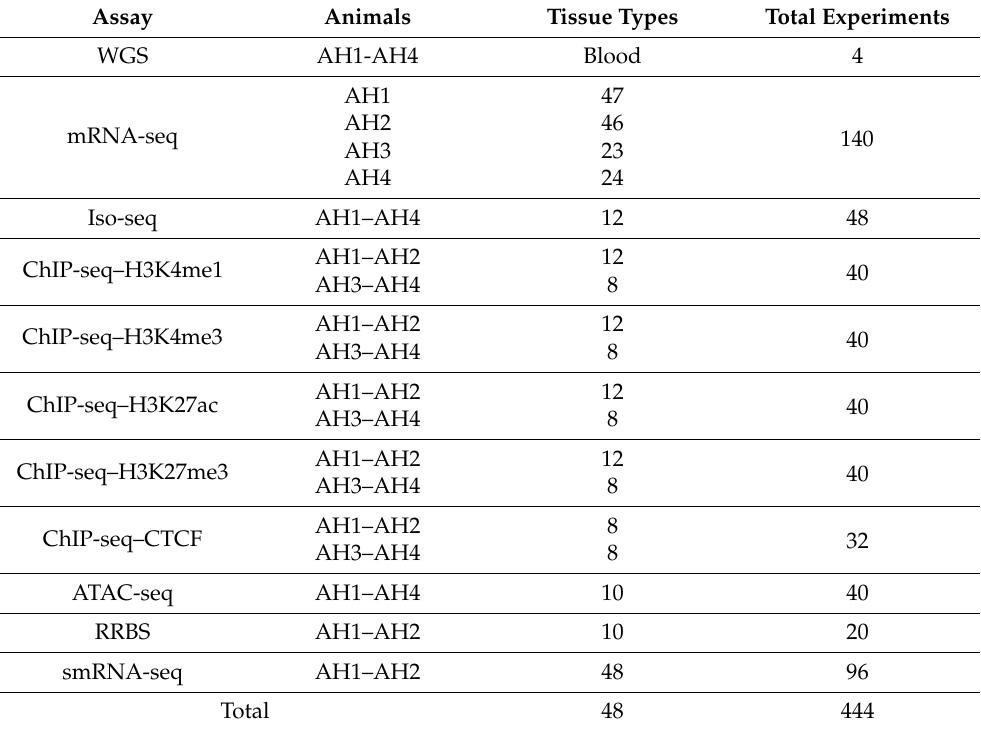
Table 2. Overview of Completed